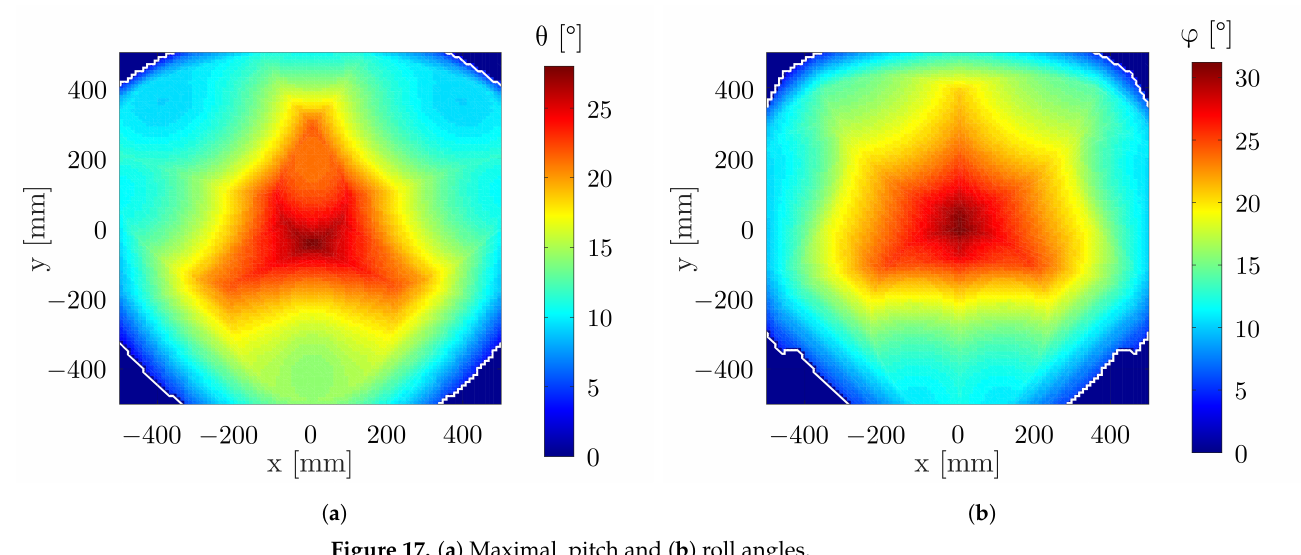
Figure 17. ( a ) Maximal pitch and ( b ) roll angles. Table 7. Maximal values of external coordinates.